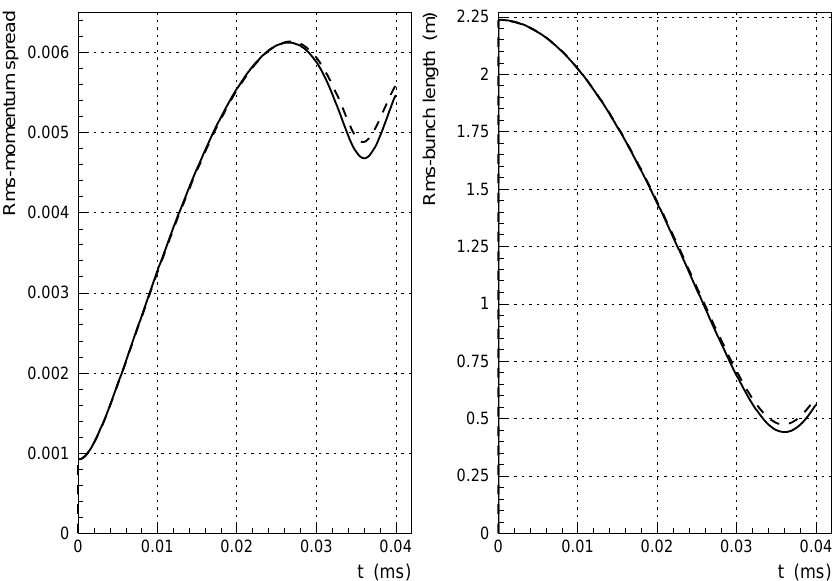
FIG. 7. Comparison of PATRIC simulation for initial parabolic and Gaussian bunch (dashed line) with h (cid:1) 2 0.05 . gained in the early part of the rotation remains conserved for the tail population. We have estimated that approxi- mately 5% of the total intensity is found in the tails beyond p 5 z rms